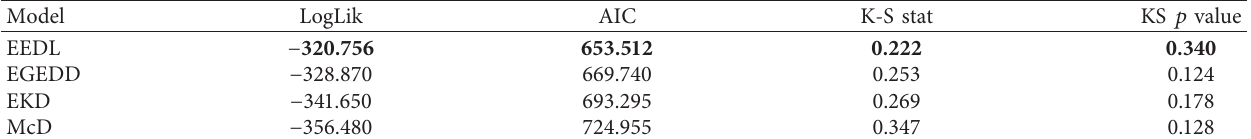
Table 4: Log-likelihood, information, and goodness-of-fit criteria for appliances data.